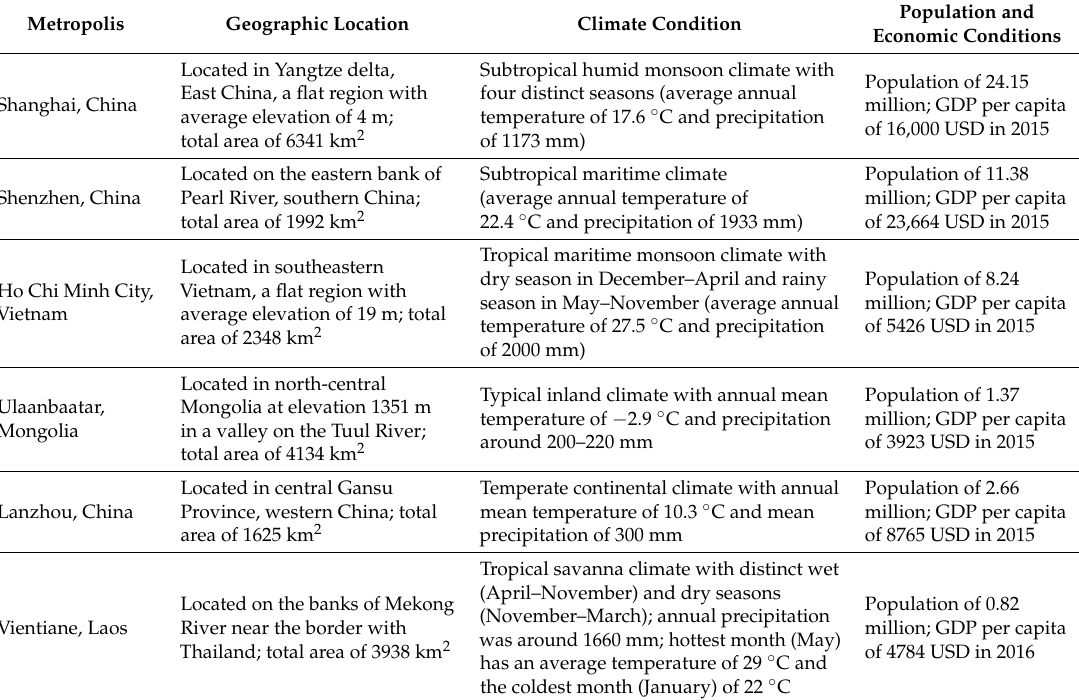
Table 1. Summary of major characteristics of the six selected